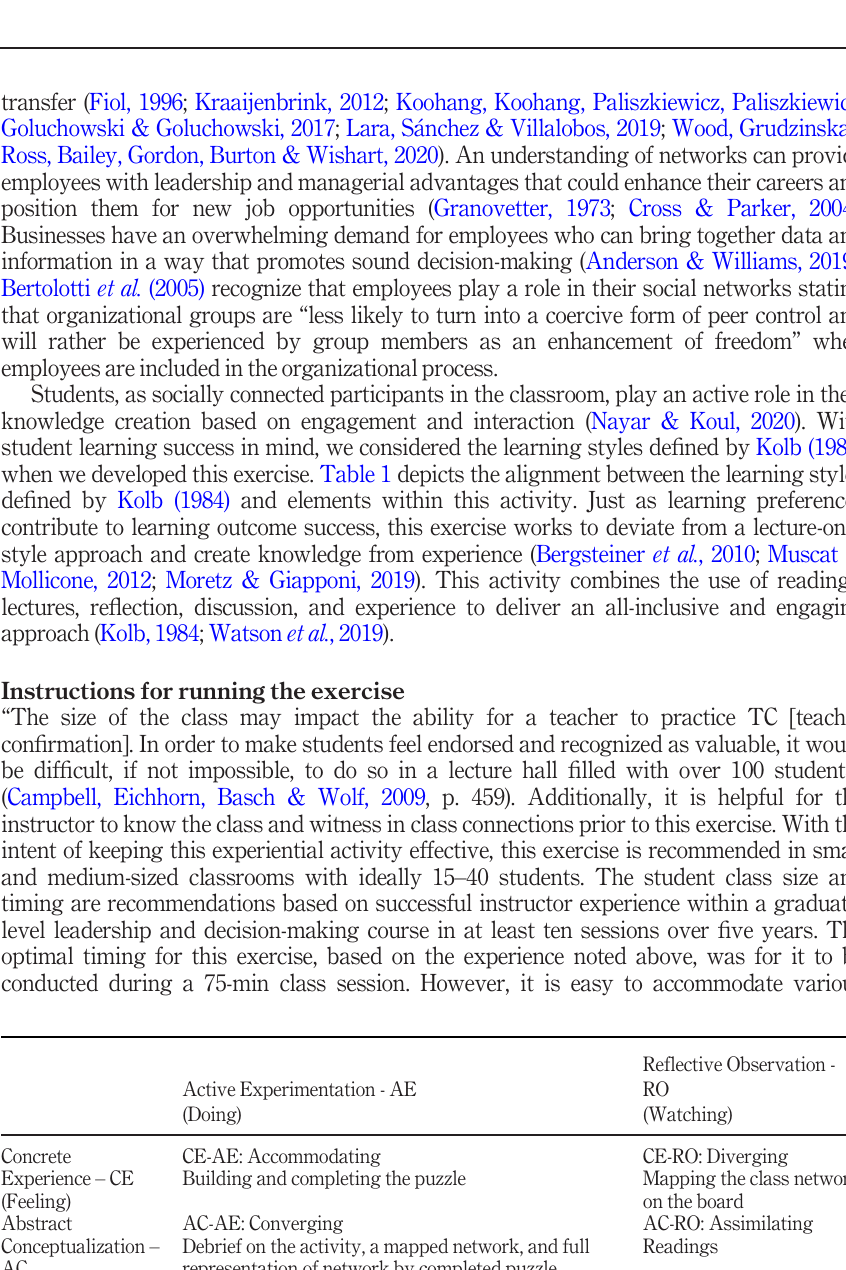
Table 1. Consideration for all Learning